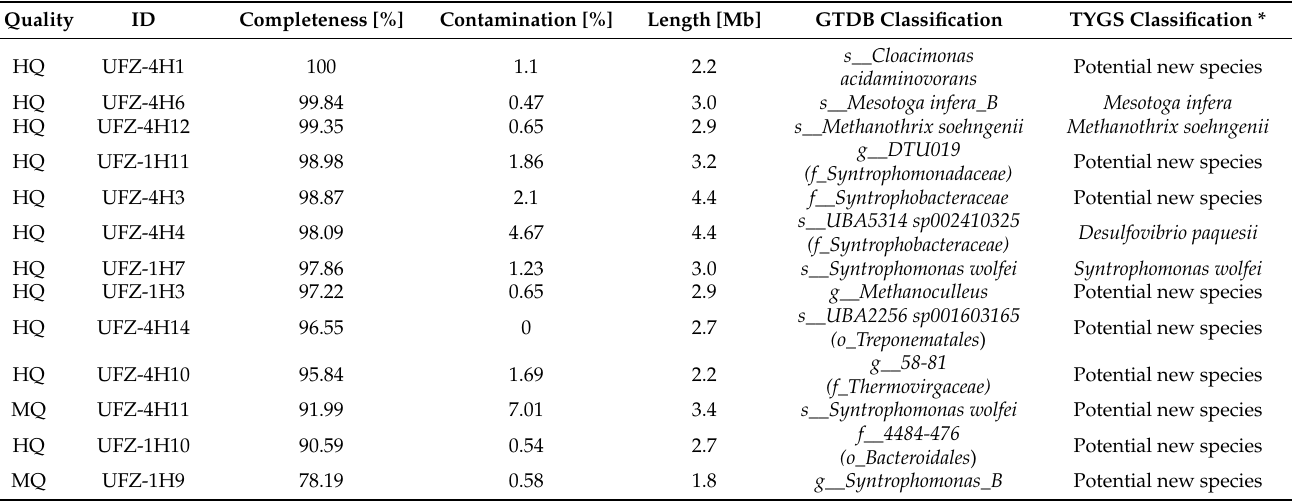
Table 3. Summary of results of hybrid assembly-based MAGs after